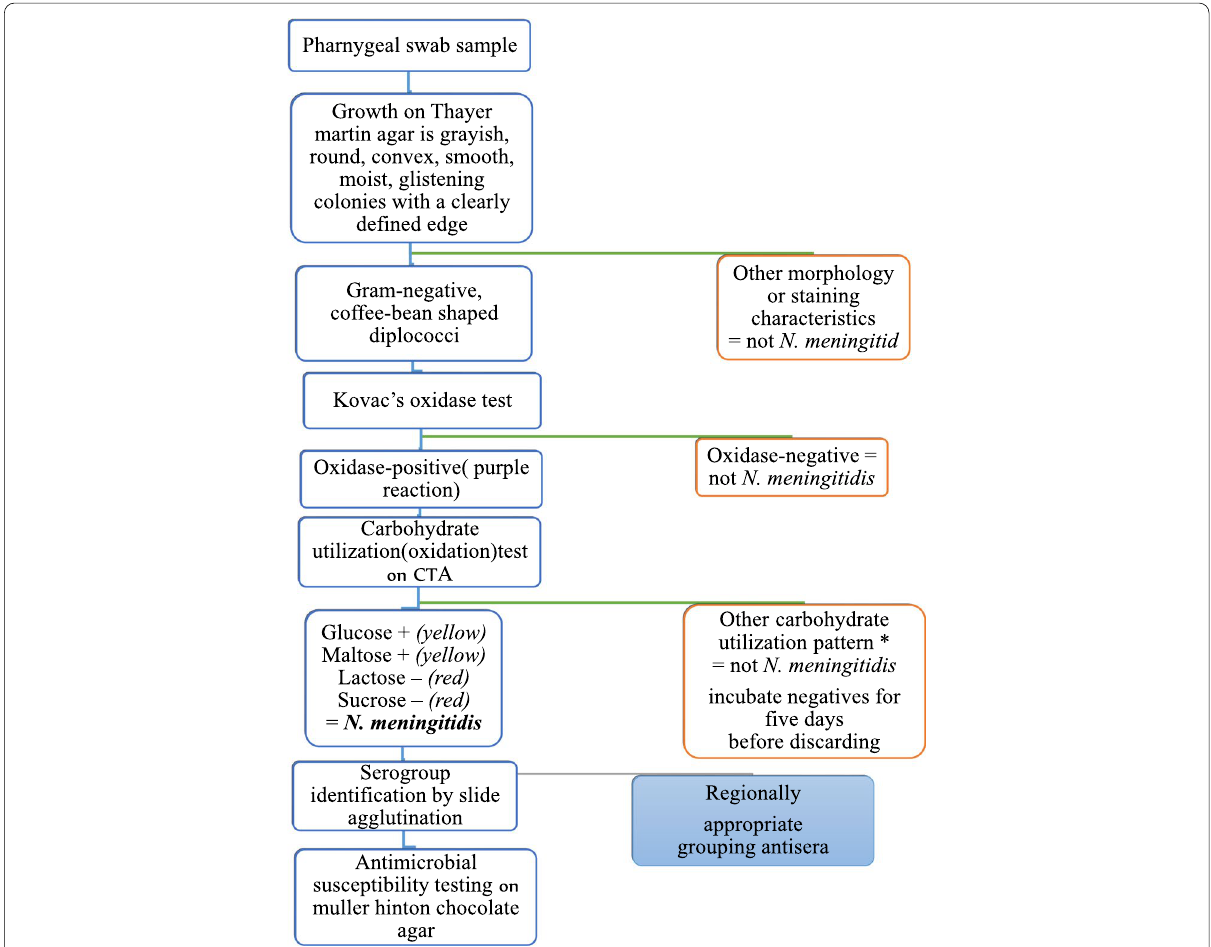
Fig. 2 Microbiological standard procedures flowchart, Jimma Ethiopia,